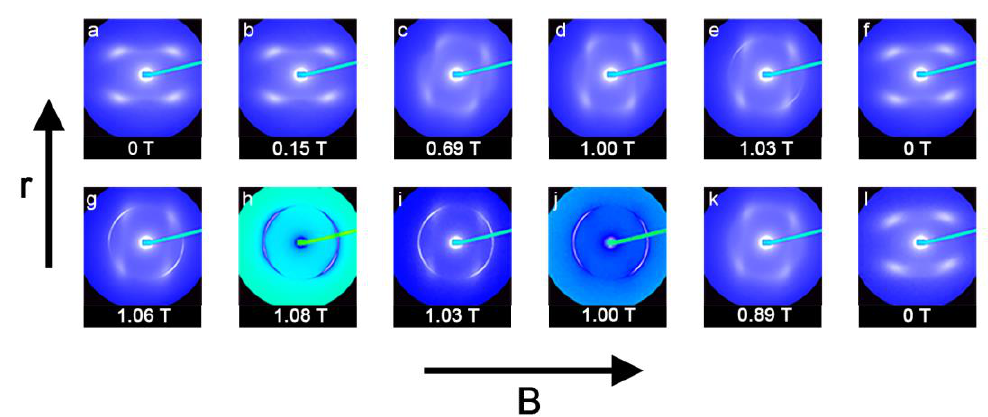
Figure 9. Low-angle XRD patterns measured for BCM 2 in a planar cell (anchoring axis r vertical) under a variable horizontal magnetic field B (field strength indicated below each pattern).